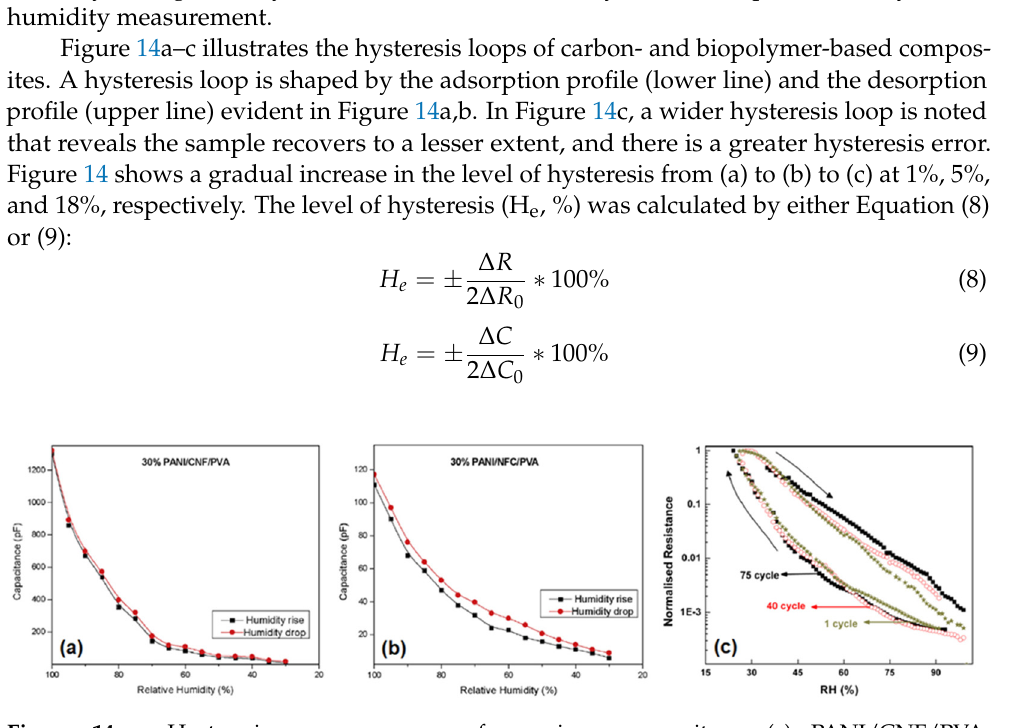
Figure 14. Hysteresis response curves for various composites: ( a ) PANI/CNF/PVA; ( b ) PANI/NFC/PVA; and ( c ) PANI/CHN. Panels ( a , b ) reprinted with permission from [12]. Copyright 2019, Elsevier. Panel ( c ) reprinted with permission from [10]. Copyright 2010, Elsevier.